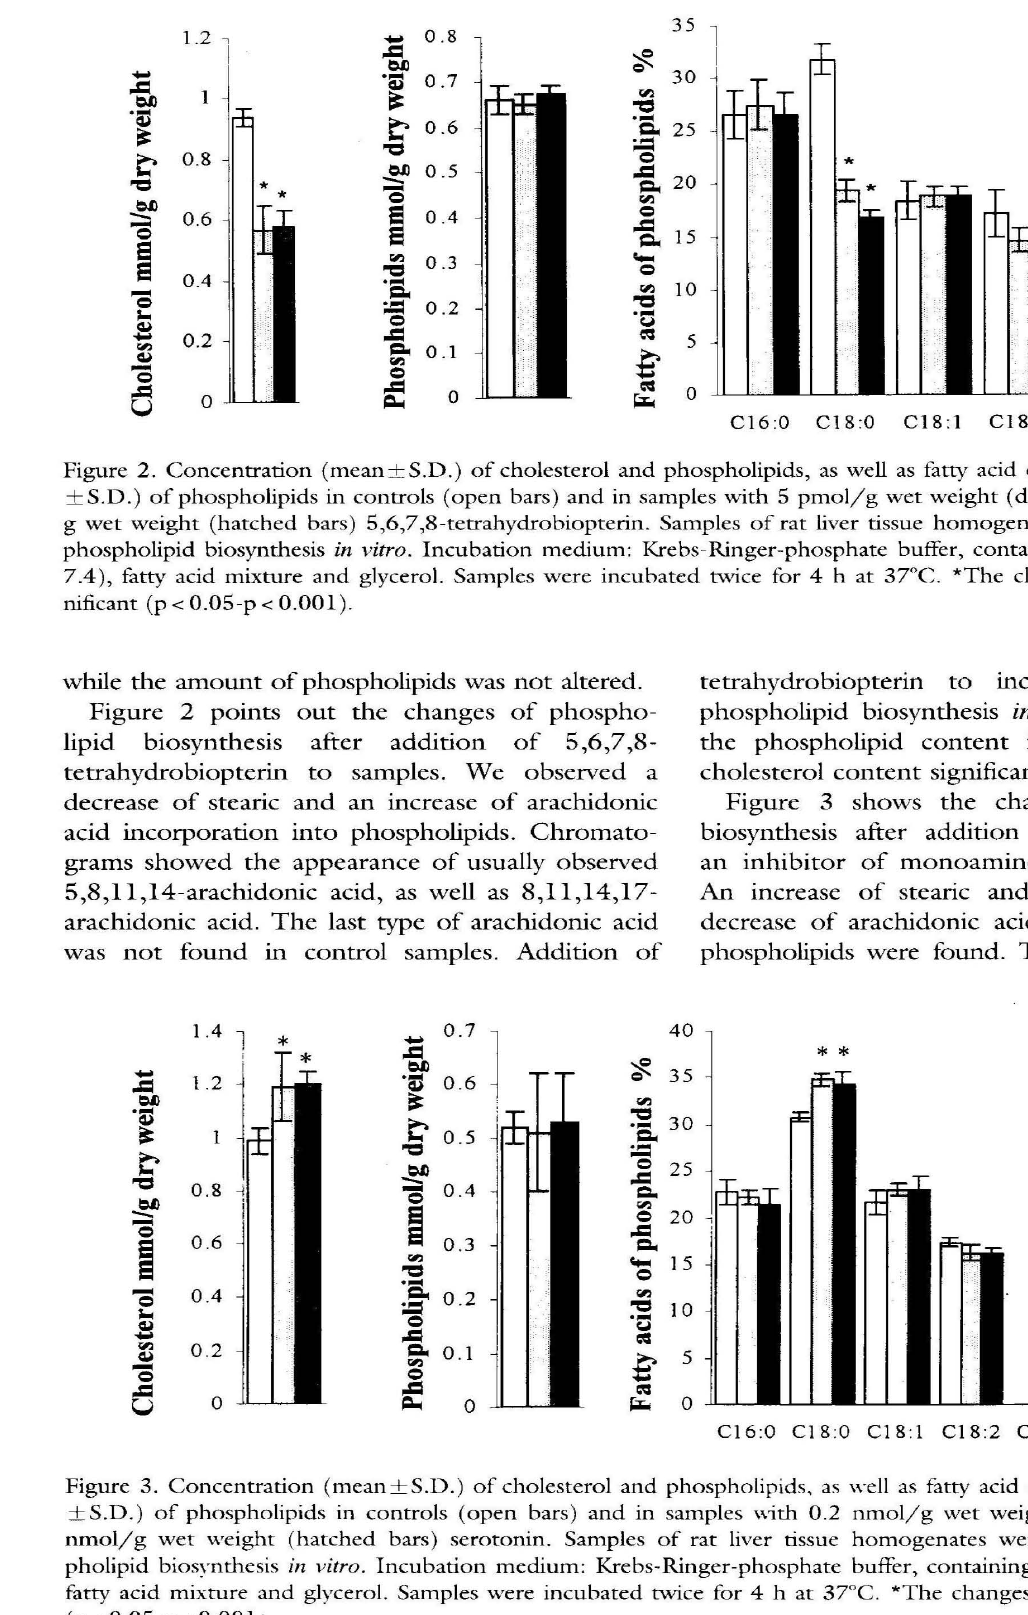
C16:0 C18 :0 CI8: 1 C18:2 CI8 :3 C20:4 C20:4 8, 1l. 14. 1 7 ~, 8.11, 14 Figure 3. Concentration (mean±S.D.) of cholesterol and phospholipids, as " ,ell as fatty acid content (in percent: mean ±S.D. ) of phospholipids in controls (open bars) and in samples with 0.2 nmoljg wet weight (dotted bars) and 2 .0 nmol/ g wet weight (hatched bars) serotonin. Samples of rat liver tissue homogenates were used to test for phos pholipid biosynthesis in vitro. Incubation medium: Krebs-Ringer-phosphate buffer, containing 0 .3% albumin (pH=7.4 ), fatty acid mixture and glycerol. Samples were incubated twice for 4 h at 37°C. *The changes are statistically significant (p < O.OS-p < 0.001